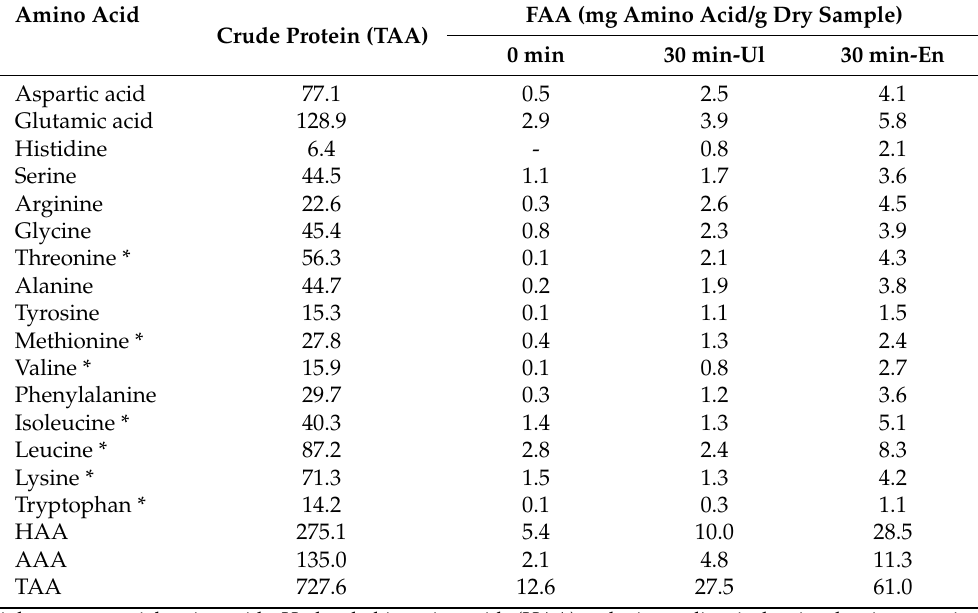
Table 1. Changes in the free amino acid (FAA) content of WPC during enzymolysis (En) and ultrasonication